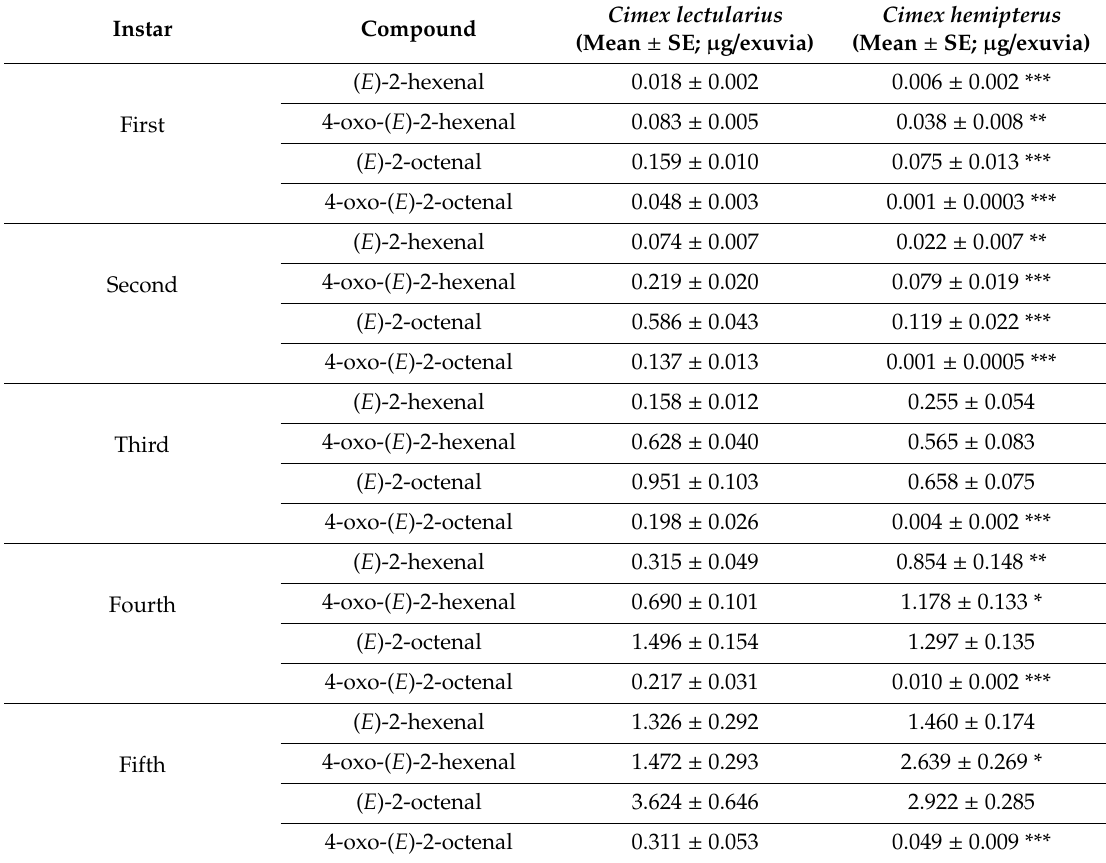
Table 2. Quantity ( µ g / exuvia; n = 10) comparisons between nymphal Cimex lectularius and Cimex hemipterus for each aldehyde compound within an instar. Significant di ff erences (Wilcoxon rank-sum test) between species are indicated in the C. hemipterus column (* p < 0.05, ** p < 0.01, *** p <